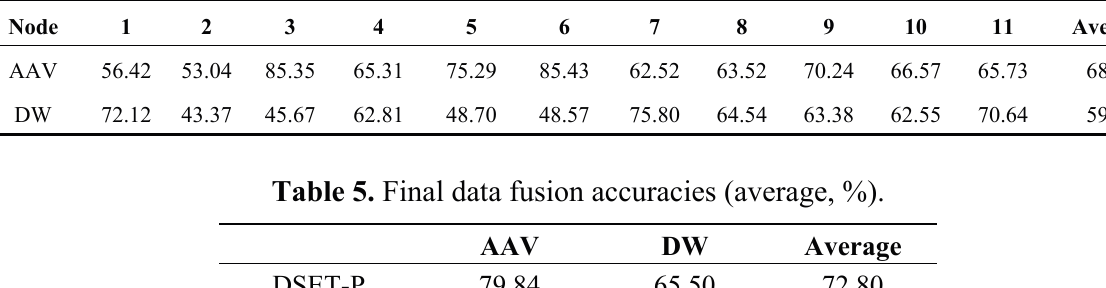
Table 4. Local classification accuracy of each sensor node (%).